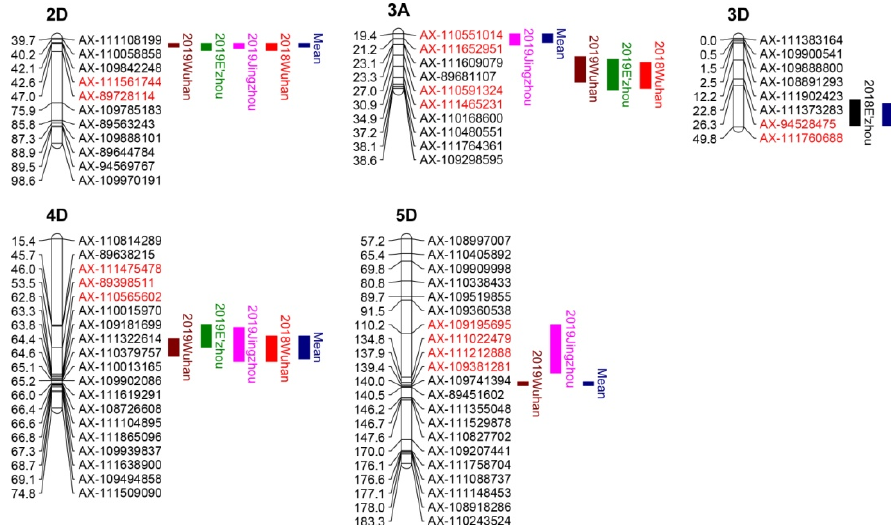
Figure 2. Chromosome locations of quantitative trait loci (QTL) for FHB resistance were detected in one